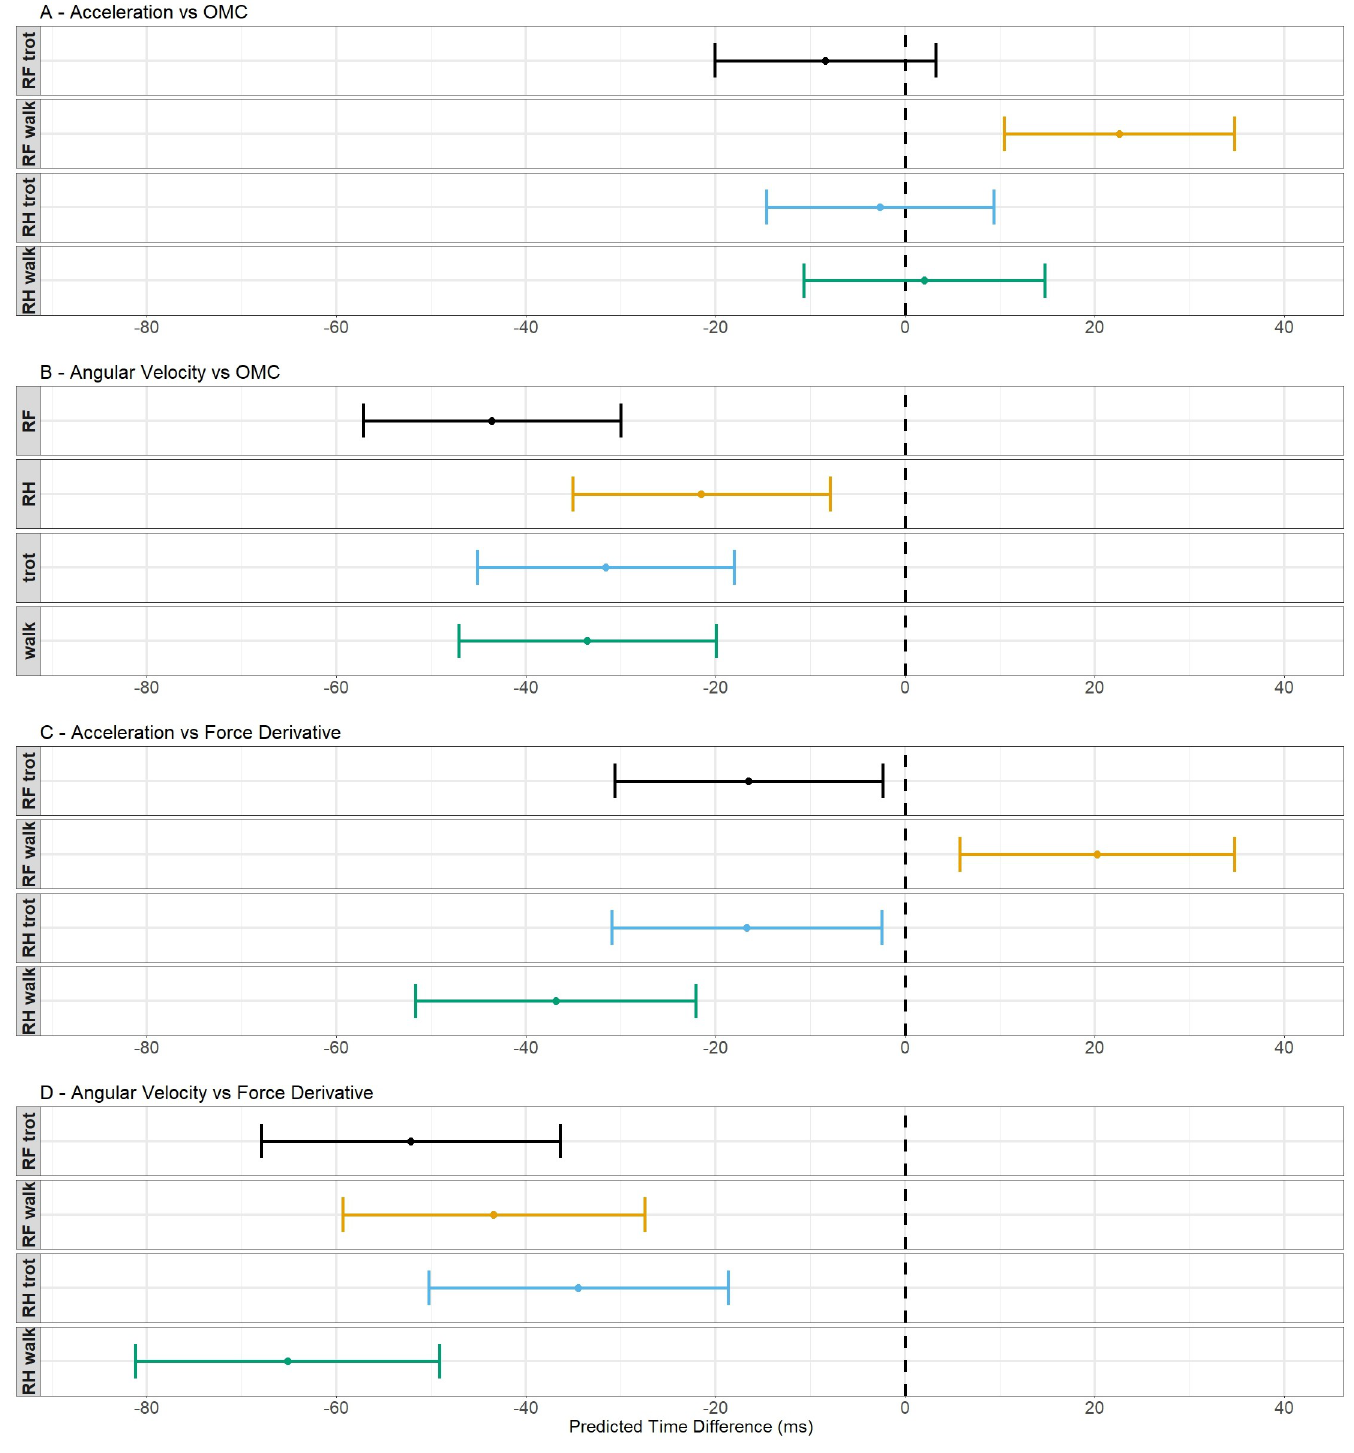
Fig 4. Schematic representation of the predicted values of the time differences and their 95% confidence intervals. The dots indicate the predicted value for a certain hoof/gait combination and the 95% confidence intervals are shown by the whiskers. The dashed line indicates a predicted time difference of 0 ms.